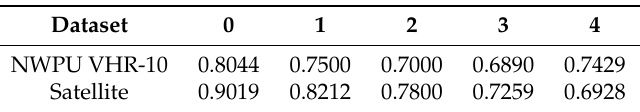
Table 5. Comparison of average precision (AP) under different iteration times of the Gamma Mixture Model (GaMM) distribution with the two